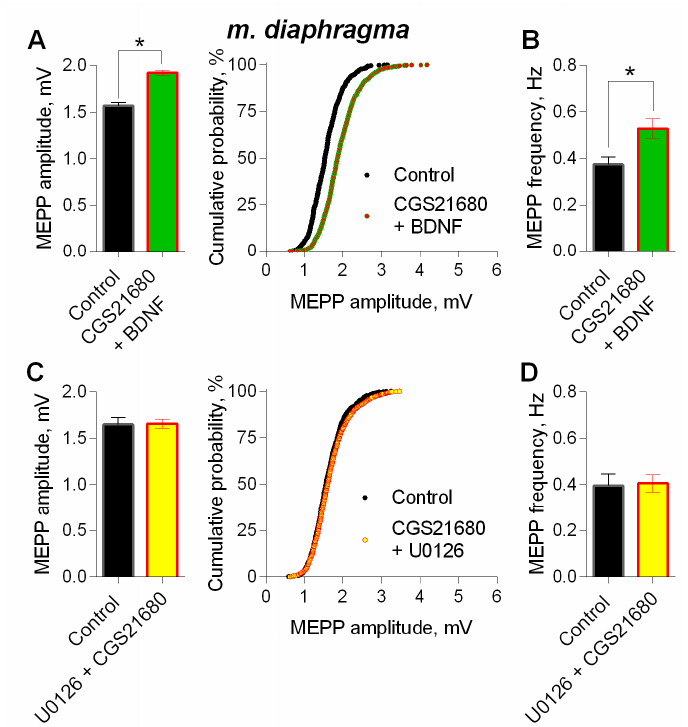
Figure 12. Intracellular signaling mechanisms underlying BDNF-induced upregulation of spontaneous neuromuscular transmission at the mouse diaphragm NMJs. The effect of BDNF (1 nM) on the MEPPs amplitude depends on coupling of A 2A -receptor-mediated and MEK1/2-mediated intraterminal pathways. ( A ) Mean amplitude of MEPPs (left) and cumulative probability plots (right) in control ( n = 23) and after BDNF was added during additional stimulation of A 2A receptors by their agonist CGS21680 (100 nM) ( n = 35). ( B ) Mean frequency of MEPPs in control and upon application of BDNF in the presence of CGS21680. ( C ) Mean amplitude of MEPPs (left) and cumulative probability plots (right) in control ( n = 15) and after CGS21680 (100 nM) was added in the presence of MEK1/2 inhibitor U0126 (20 nM) ( n = 24). ( D ) Mean frequency of MEPPs in control and upon application of CGS21680 in the presence of U0126. * p < 0.05 compared to control.